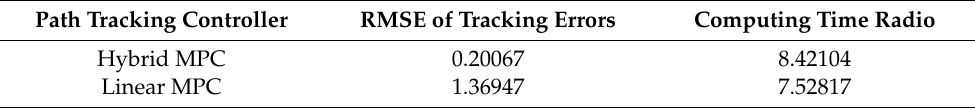
Figure 7. Simulation results in low-adhesion DLC scenario. ( a ) Path tracking performance; ( b ) Yaw rate comparison; ( c ) Steering angle comparison; ( d ) Yaw moment comparison. ( e ) State trajectories of sideslip angle and yaw rate. Table 2. Comparison of tracking errors and computing time of two